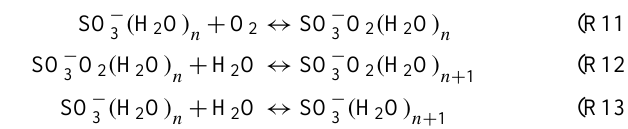
Fig. 8. Lifetime of the reactant complexes, O − dard conditions. For comparison, the average times between colli- sions, τ , with N 2 , O 2 and H 2 O (50% RH) are